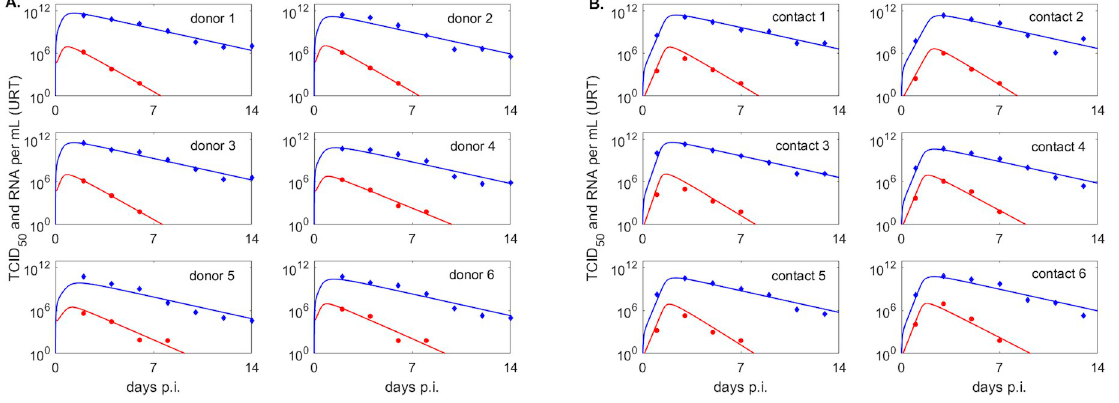
Fig 4. Infectious virus and viral RNA dynamics in upper respiratory tract of donor and contact groups. Dynamics of infectious virus V (red lines) and viral RNA R u (blue lines) as given by model Eq 3 versus infectious viral titers (red circles) and viral RNA (blue diamonds) in the upper respiratory tract of (A.) donors, (B.) contacts with fixed initial virus, V 0 = 1. Model parameters are given in Table